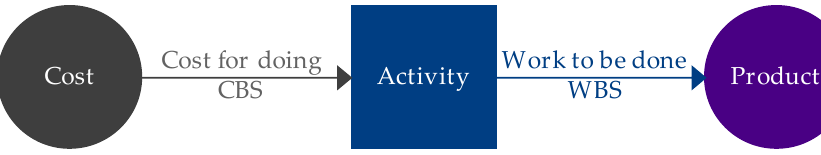
Figure 3. Activity-based costing in the construction industry.